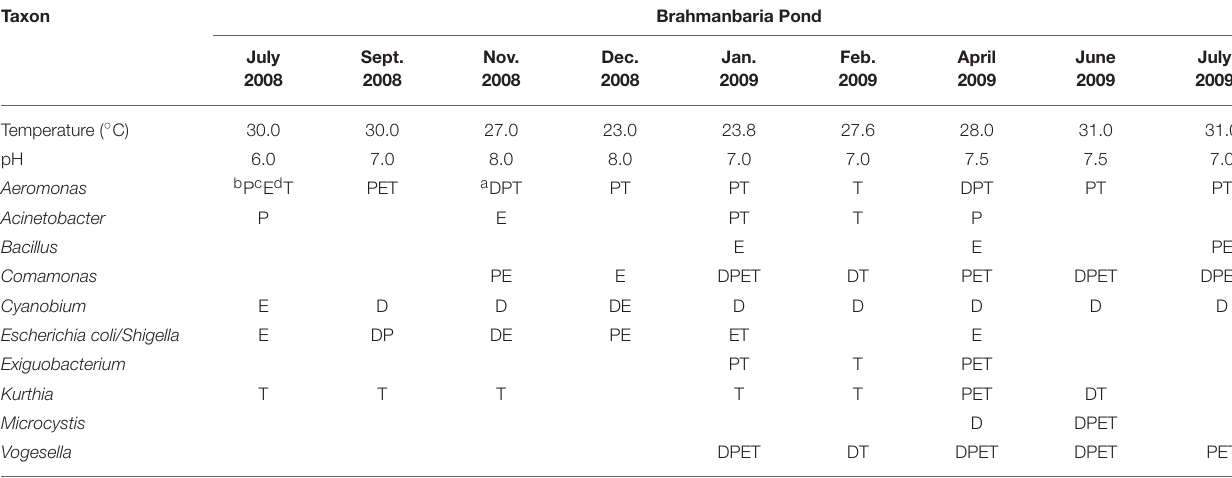
TABLE 1 | Distribution of bacterial genera in Brahmanbaria Pond in July 2008–2009. Taxon